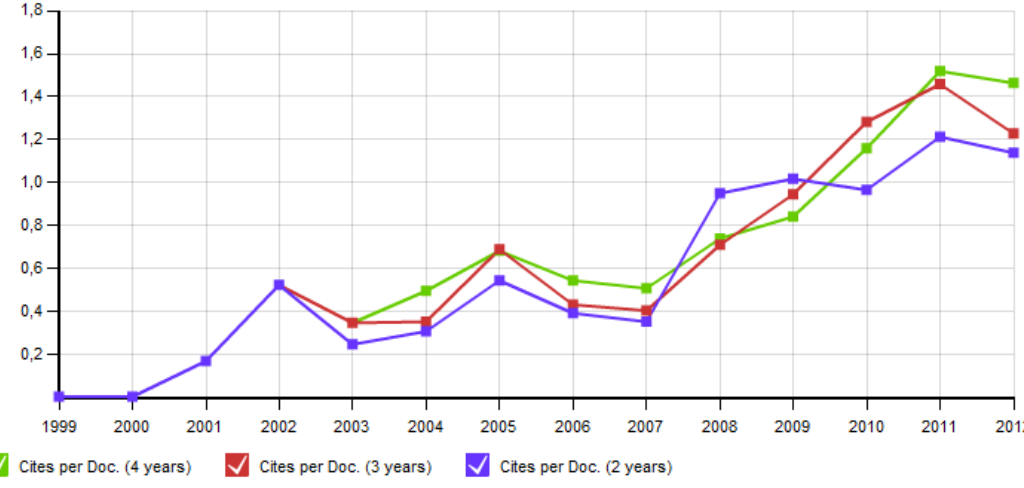
Figure 2. The incremental growth of the citation count in 2, 3 and 4 previous years. Source: SCImago Journal & Country